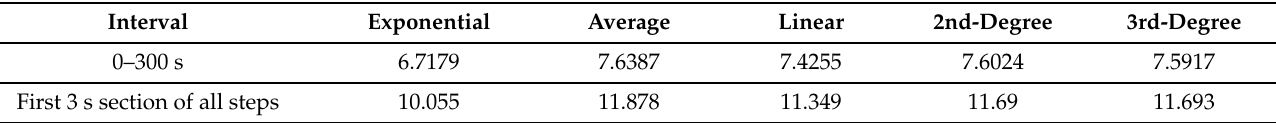
Table 8. Standard deviations for the different proposed models.